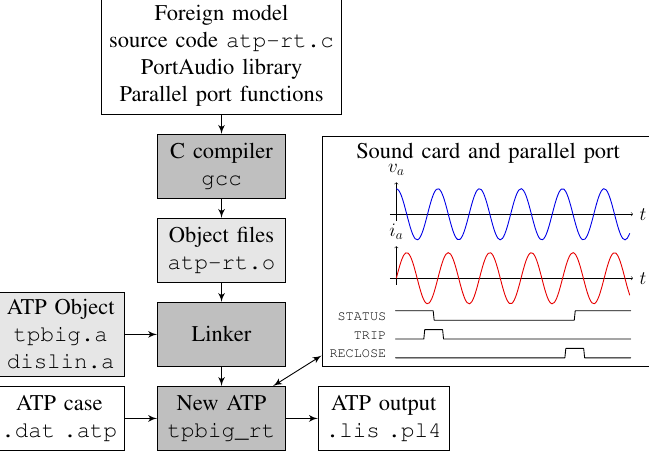
Figure 1. Alternative Transients Program (ATP) foreign model compilation including the PortAudio